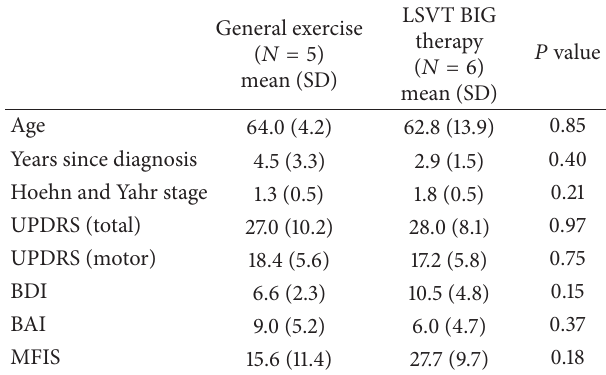
Table 1: Demographic and clinical characteristics at